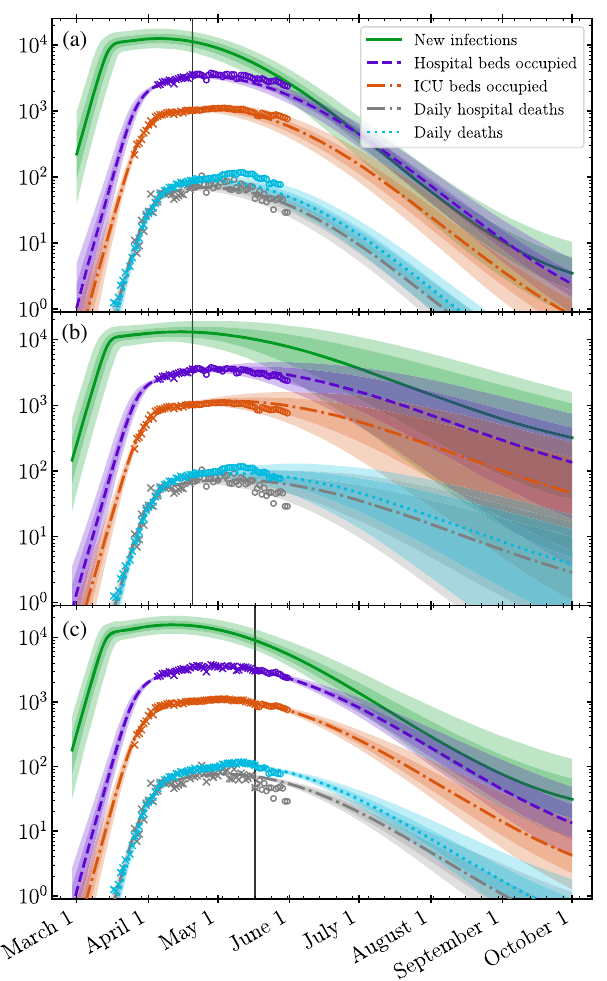
FIG. 2. Fits and predictions of our model of the entire state of Illinois under the continuation of the stay-at-home order and social-distancing measures, resulting from parameter inference, ¼ 0 . 2 and calibrates to data through April which (a) fixes A SF 20, 2020, (b) samples A and calibrates to data through April SF 20, 2020, and (c) samples A and calibrates to data through SF May 17, 2020. In each case, the data used for calibration are denoted by crosses, while data from later dates (open circles) allow a comparison of model predictions with subsequent real- world observations. Each panel ’ s vertical line marks the end of data used for calibration. Solid curves denote median model predictions at a given time, while the shaded regions denote the 68.4% (darker shading) and 95.6% (lighter shading) confidence intervals of a particular output. We depict the daily incidence of new infections (green, solid line), the number of occupied hospital beds by confirmed or tentative COVID-19 patients (purple, dashed line), the number of ICU beds occupied by confirmed COVID-19 patients (orange, dot-dashed line), the number of hospital deaths by confirmed COVID-19 patients (grey, dot-dashed line), and total daily deaths of COVID-19 patients (light blue, dotted line). We remove reporting artifacts by plotting daily-death data smoothed by a 7-day running